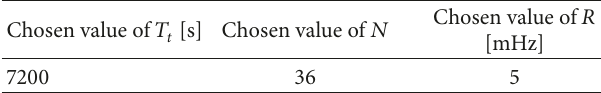
Table 3: Chosen values of 𝑇 𝑡 , 𝑅 , and 𝑁 to be used in OMA with real signals.